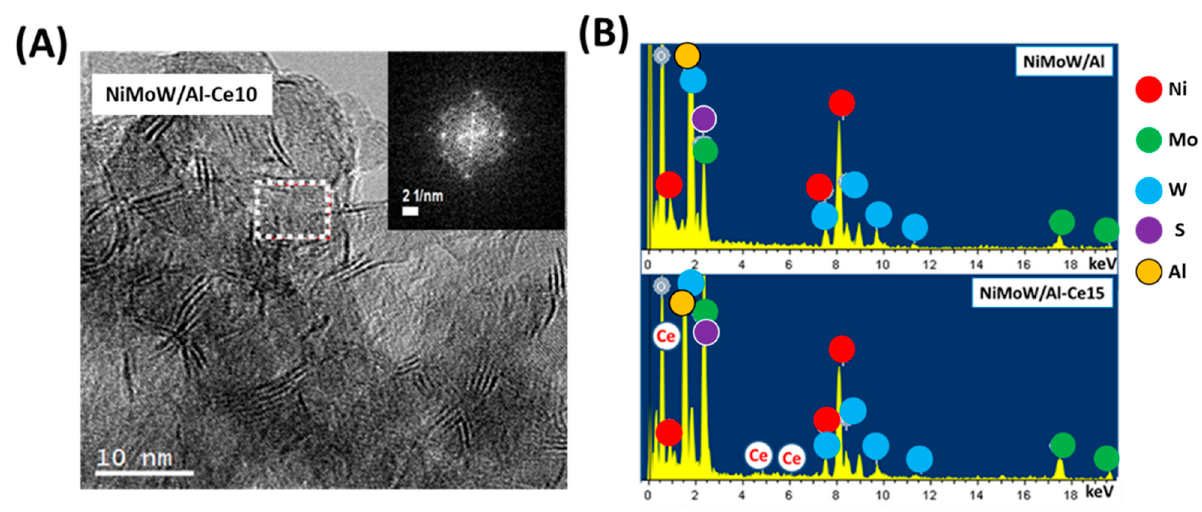
Figure 11 . ( A ) HRTEM image of the used NiMoW/Al ‐ Ce10 catalyst. The inset shows the fast Fourier transform (FFT) image corresponding to its selected area showing the cubic symmetry of the CeO 2 structure. ( B ) EDS spectra of used NiMoW/Al and NiMoW/Al ‐ Ce15 catalysts .